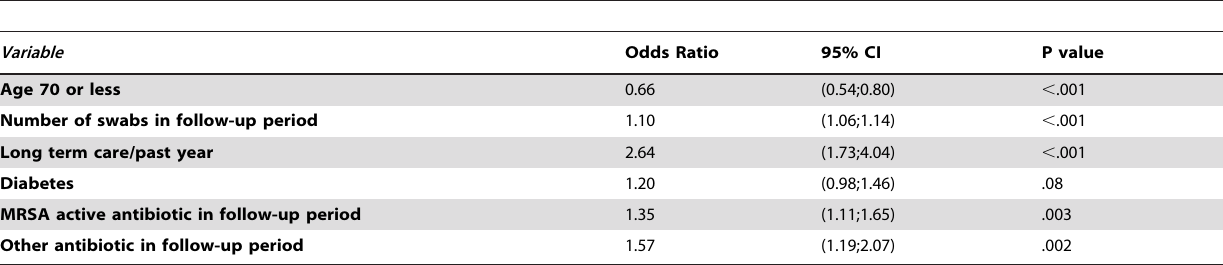
Table 3. Multivariable model of risk factors for conversion from a non-colonized nasal MRSA carriage pattern to colonized over the next 6 months.